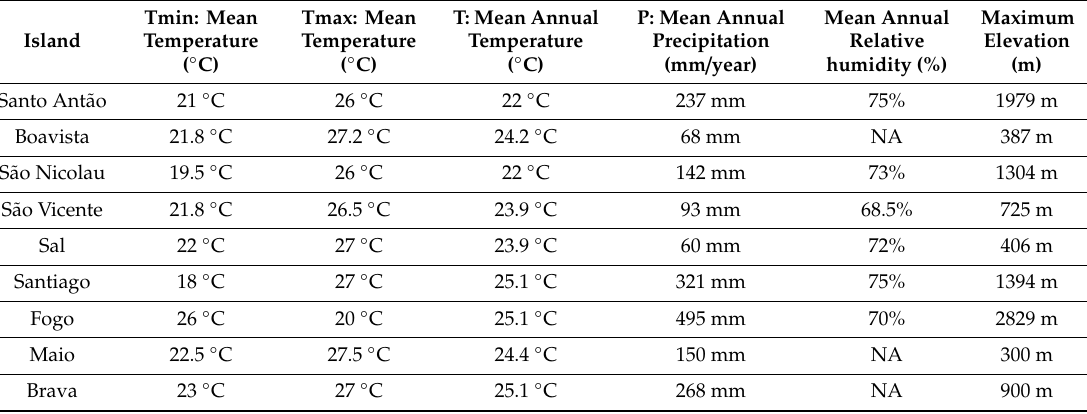
Table 1. Climatic variables (mean annual temperature, mean annual precipitation, mean annual relative humidity) for each inhabited island of Cabo Verde